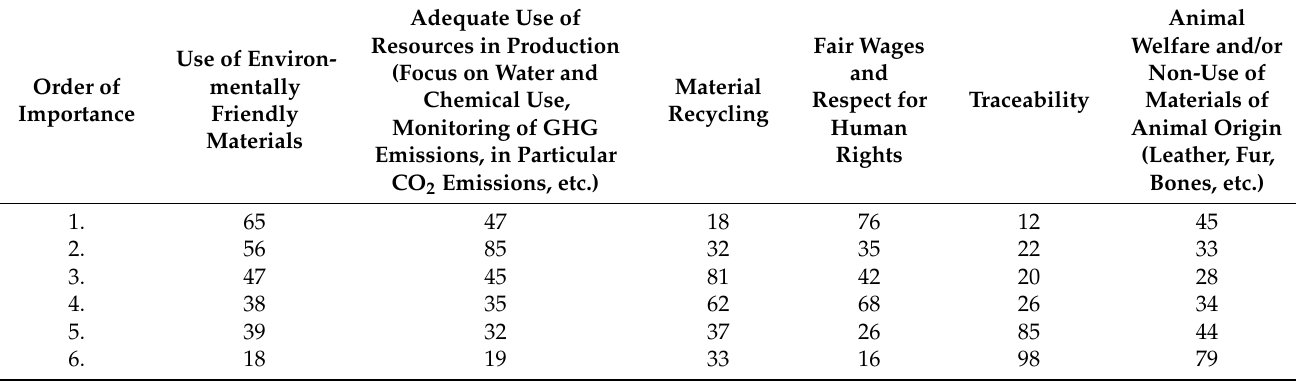
Table 3. Overall ranking of factors considered in deciding to buy a clothing item in order of impor- tance to